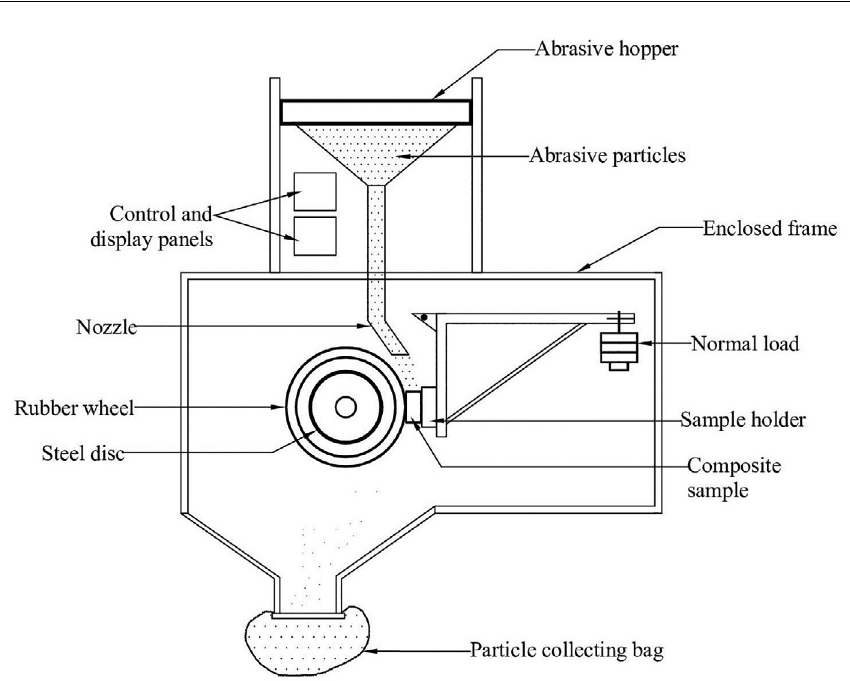
Figure 1. Schematic diagram of abrasive wear test